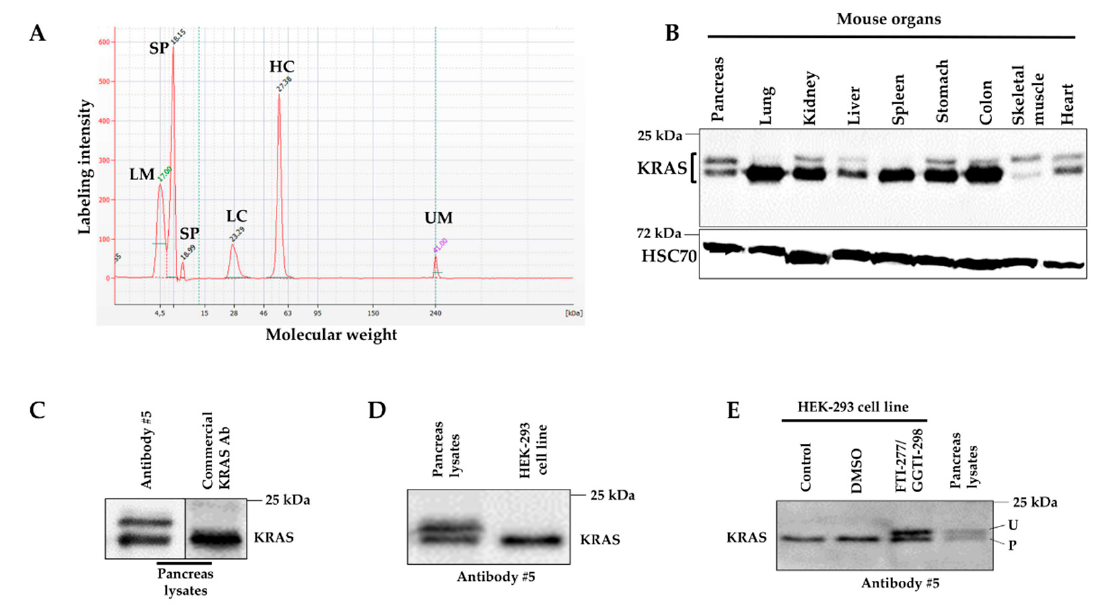
Figure 4. Detection of endogenous unprenylated and prenylated KRAS forms in mouse tissues. ( A ) SDS-page micro-electrophoresis showing the profile of purified antibody #5 after affinity chromatography purification. ( B ) Western blot performed on proteins extracted from mouse organs ( n = 2). HSC70 is used as loading control. ( C ) Western blot performed on pancreas lysates using either antibody #5 or a commercial KRAS antibody (WH0003845M1, Sigma Aldrich) ( n = 3). ( D ) Western blot performed on pancreas lysates and HEK-293 lysates using antibody #5 ( n = 3). ( E ) Western blot performed using antibody #5 on lysates from the pancreas and HEK-293 cells which were not treated (control), DMSO-treated, and FTI-277/GGTI-298-treated ( n = 3). U: unprenylated; P: prenylated. LM: lower marker; SP: system peak; LC: light chain; HC: heavy chain; UM: upper marker.